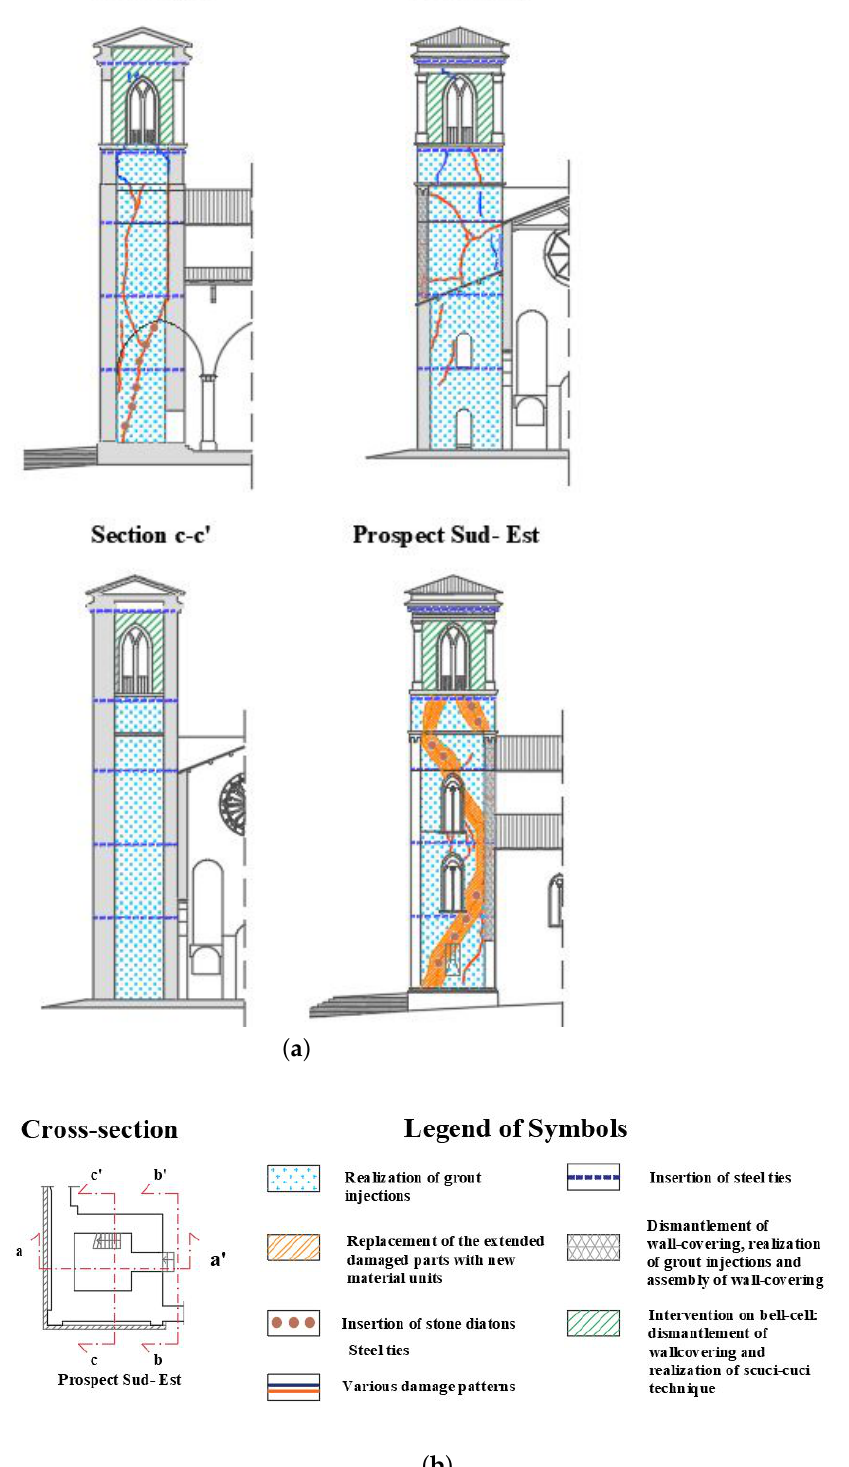
Figure 18. Restoration of the St.Silvestro belfry: ( a ) Representation of the restoration measure; ( b ) Cross-section and